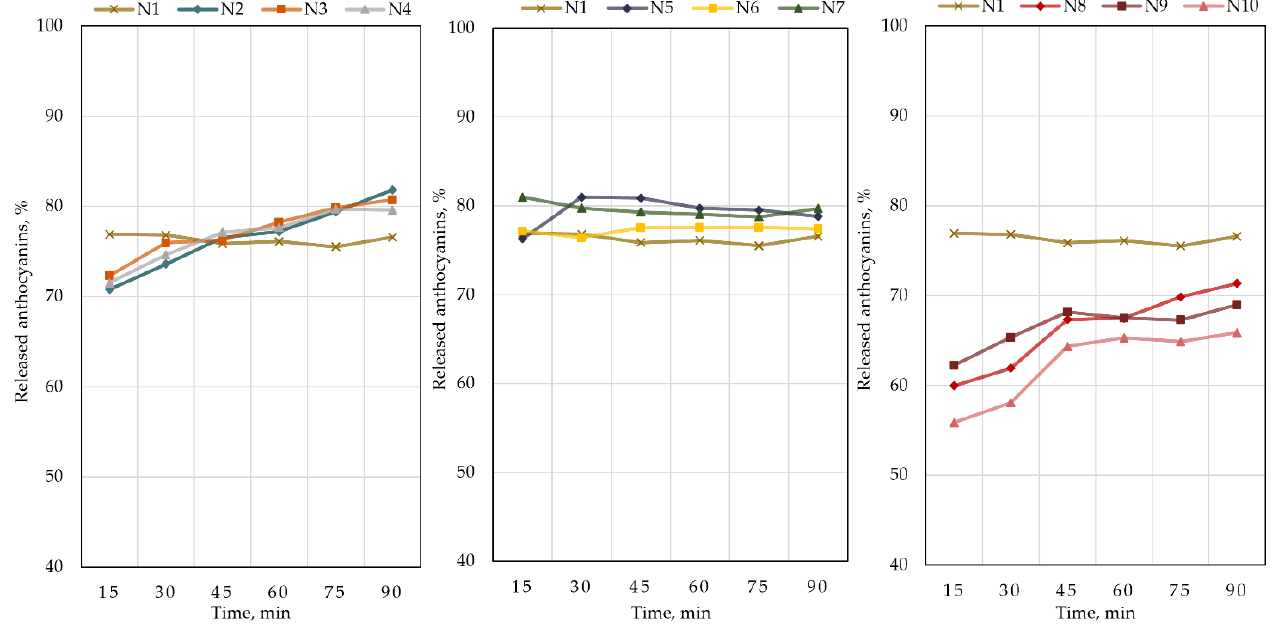
Figure 5. Results of the dissolution test of cranberry lyophilizate-containing capsules of different compositions. The compositions of the capsules (N1–N10) are described in Table 1.